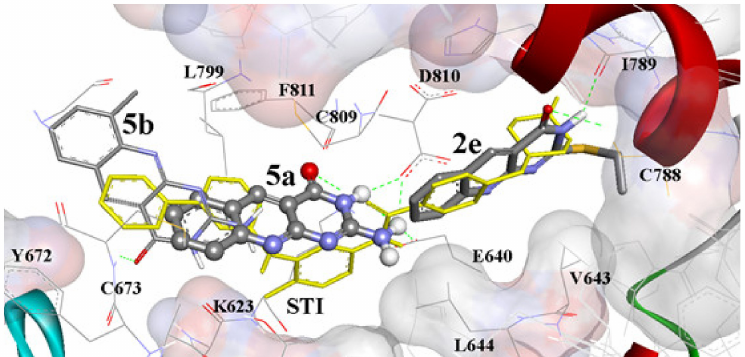
Figure 12. Di ff erential docking a ffi nities of compounds 2e (bold sticks), 5a (ball and stick) and 5b (thin sticks) involving flexible docking into c-Kit PTK (1t46). Where compounds 2e and 5a seem docked exactly superimposed on the native STI ligand (yellow sticks) revealing two and four hydrogen bonds, whereas, 5b has deviated away with only one hydrogen bond. The c-Kit PTK is shown as a solid backbone ribbon and the hydrogen bonds as green dotted